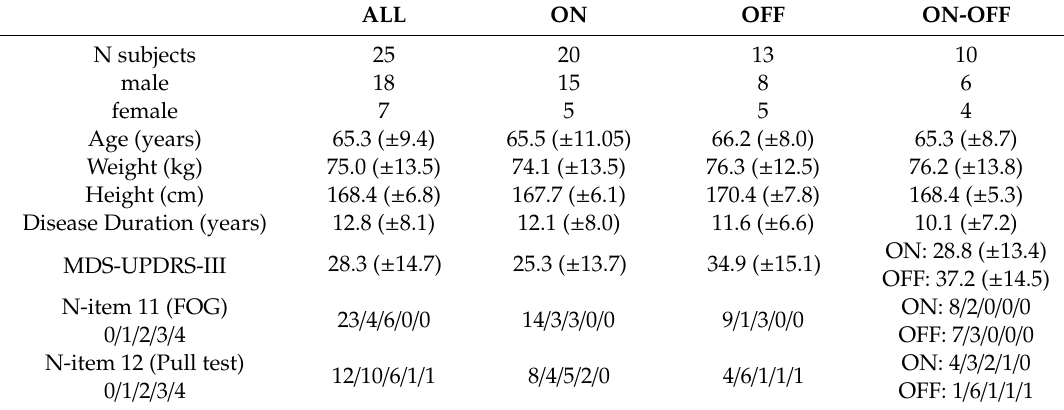
Table 1. Description of subgroups, where metrical measures are given as mean and standard deviation and ordinal data as number of reached scores for each